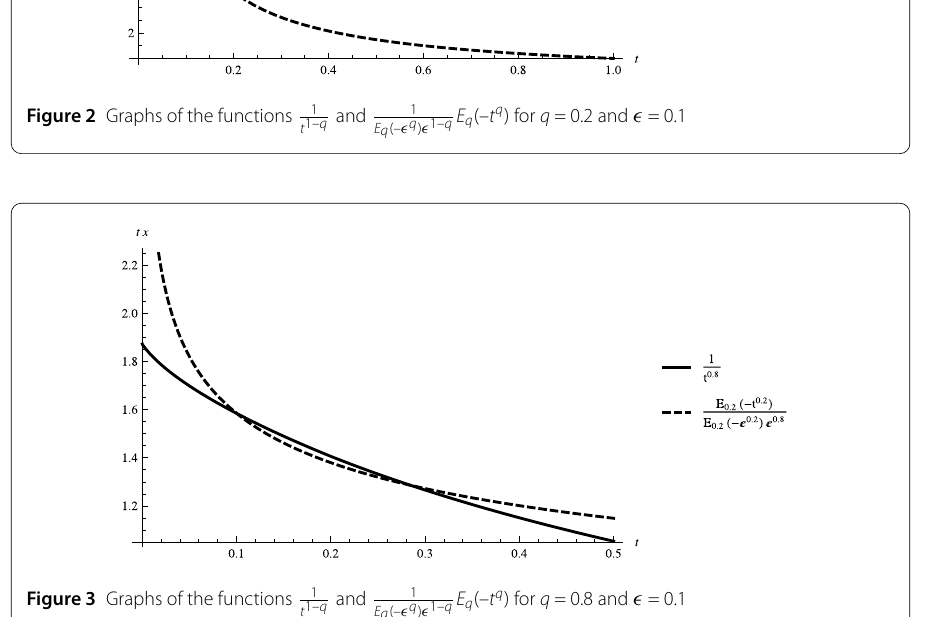
Figure 3 Graphs of the functions 1